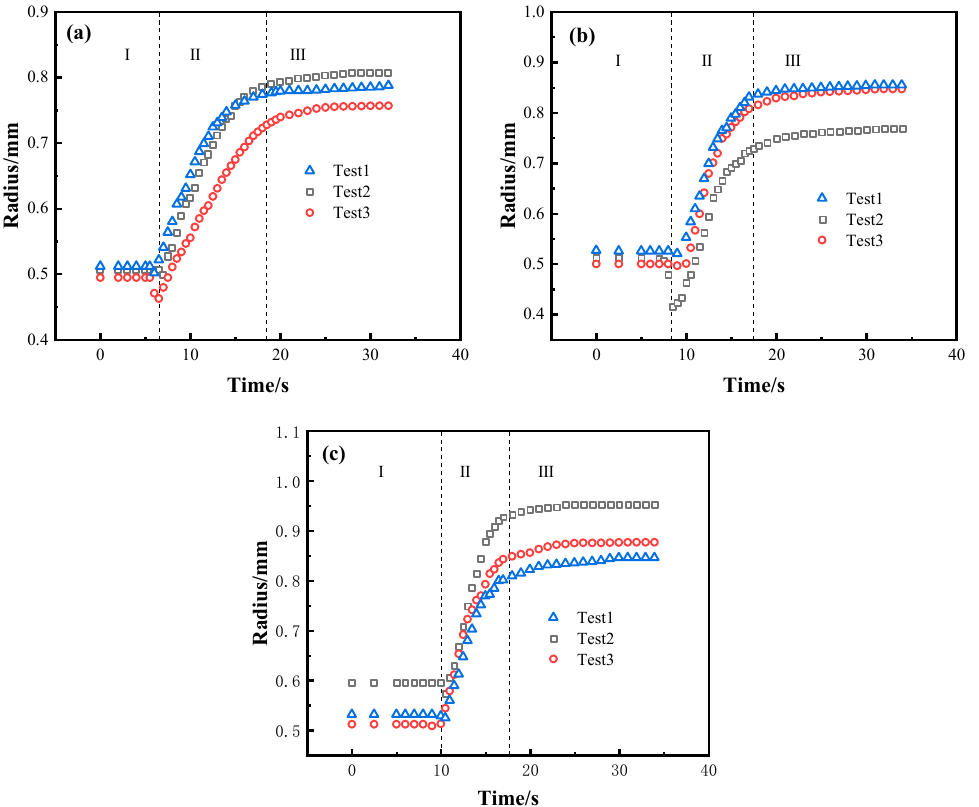
Figure 5. The relationship between the equivalent spreading radius and time of the BNi2/SLMed TC4 wetting system at: ( a ) 1020 °C; ( b ) 1080 °C, and ( c ) 1150 °C.